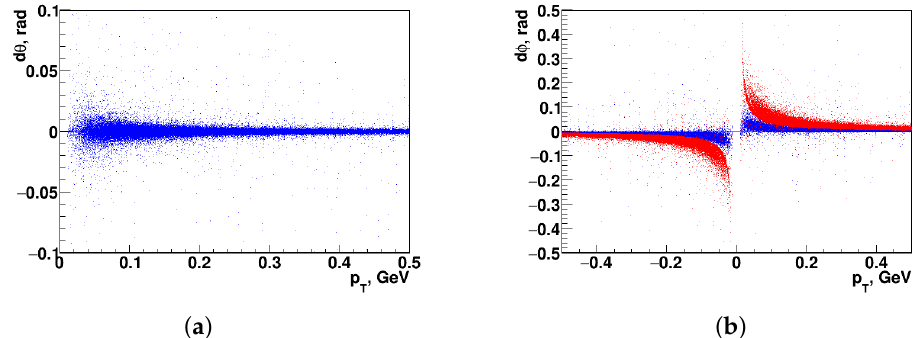
Figure 3. ( a ) Longitudinal angle difference of hits on sequential layers dtheta as a function of p T for primary tracks. ( b ) Transverse angle difference of hits on sequential layers dphi as a function of signed p T for primary tracks. Different colors correspond to different distances between detector layers.